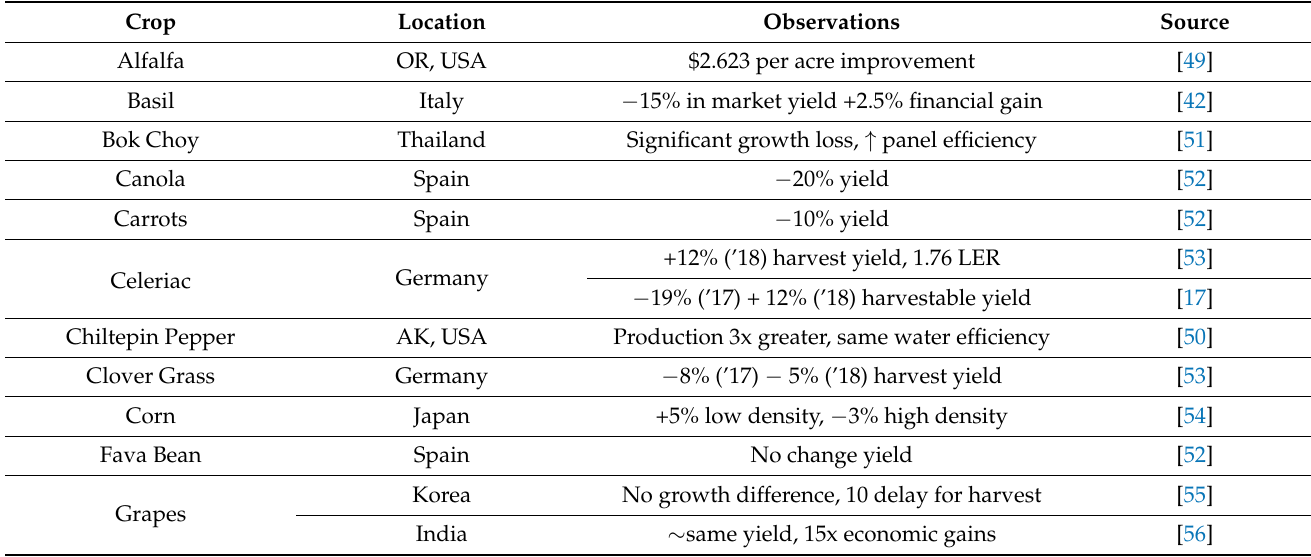
Figure 7. Lettuce experiment conducted by [24]. Table 3. Impacts of AV on crop development in field